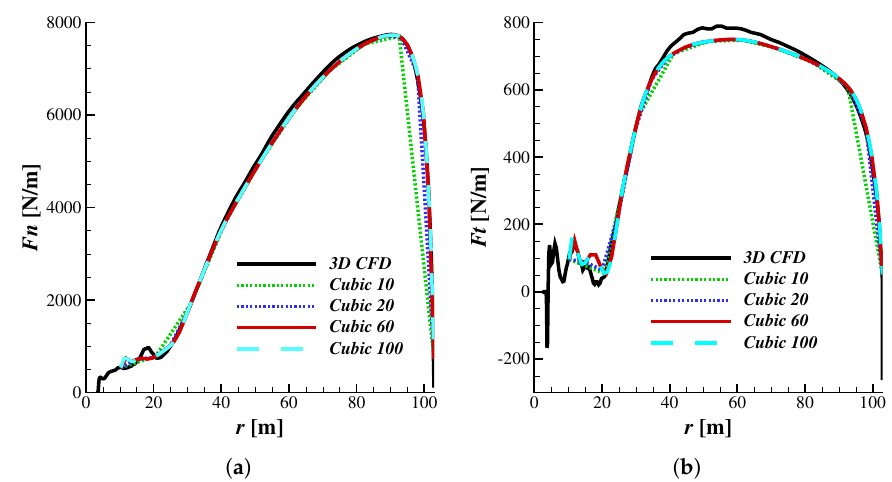
Figure 15. Effects of blade element discretization for radial-cubic spline interpolation on the sectional force distributions along the blade radius; ( a ) normal force, ( b ) tangential force.